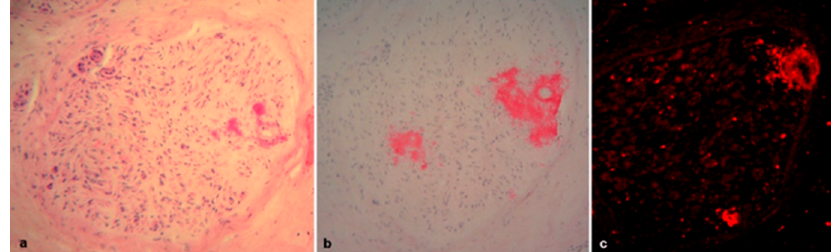
Figure 6. Sural nerve biopsy from a 73 ‐ year ‐ old Val30Met hATTR patient. H&E staining ( a ) showed abundant TTR amyloid deposition confirmed also by Congo red staining ( b ) and by immunofluorescence with anti ‐ TTR antibodies ( c ).